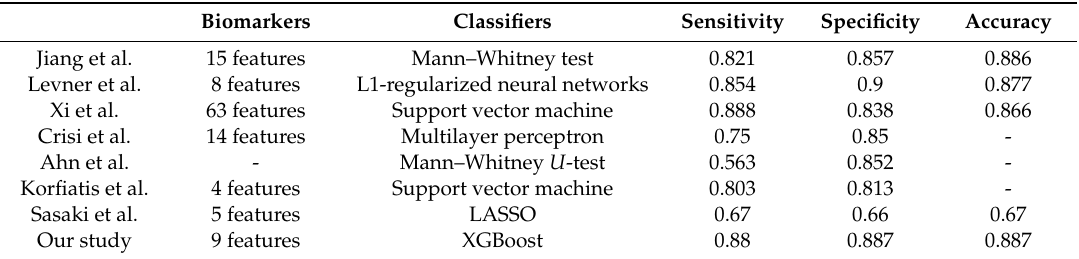
Table 4. Comparison between our models and previously published works in predicting MGMT mutation status in